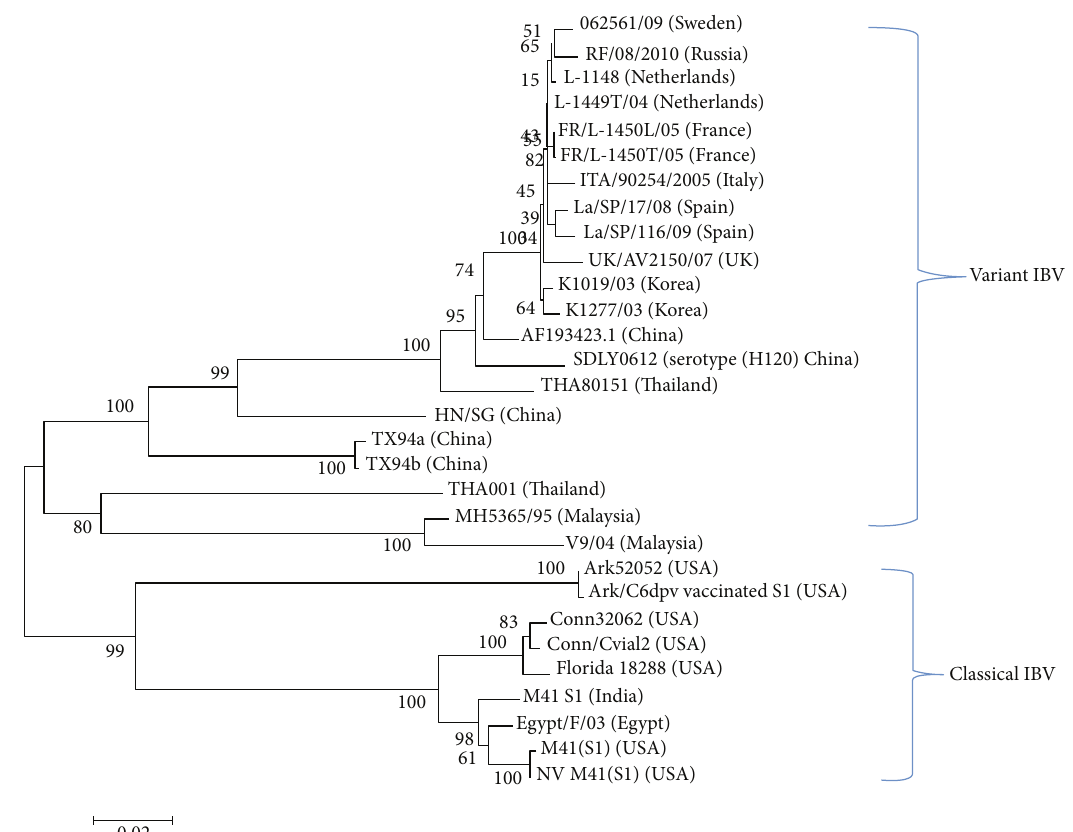
Figure 11: Neighbour joining phylogenetic analysis based on nucleotide acid sequence of S1-spike gene of classical and variant IBV strains identified in different countries. The tree was drawn with MEGA5 software using 1000 bootstrap